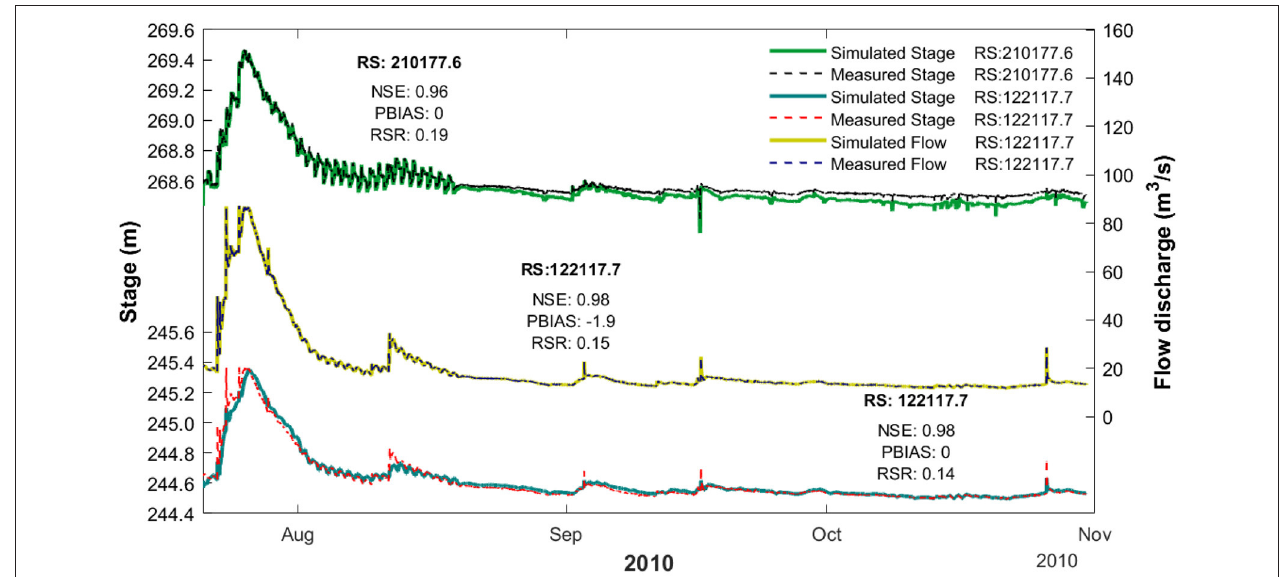
FIGURE 5 | Comparison between measured and simulated water surface elevation at U.S. Geological Survey (USGS) gaging station 04103500 Kalamazoo River at Marshall, Michigan [top, River Station (RS) 210177.6] and USGS gaging station 04105500 Kalamazoo River near Battle Creek, Michigan (bottom, RS 122117.7) (U.S. Geological Survey, 2020). The datum is in NAVD 88. Comparison between measured and simulated flow discharge at USGS gaging station 04105500 Kalamazoo River near Battle Creek, Michigan (middle, RS 122117.7) (U.S. Geological Survey, 2020). NSE, Nash-Sutcliffe efficiency; PBIAS, percent bias; RSR, ratio of the root-mean-square error to the standard deviation of measured